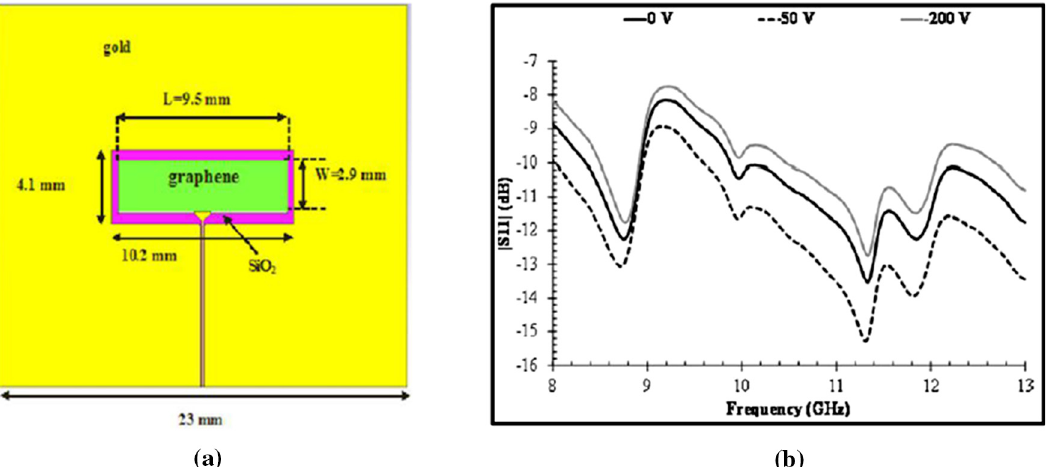
Fig. 7. (a) The con fi guration of the tunable microwave slot antenna. (b) Measured | S 11 | of antenna in X band with three different bias voltages.